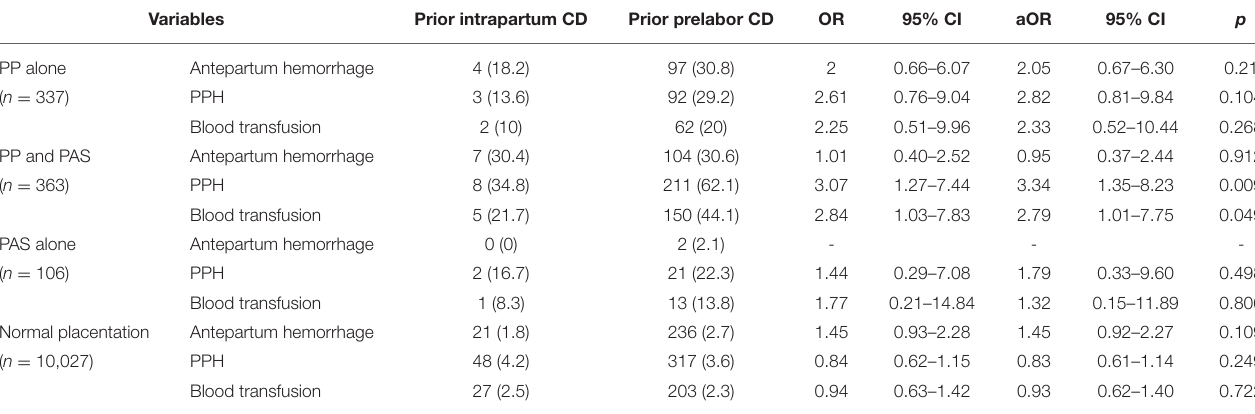
TABLE 3 | Multivariate logistic regression analysis in pregnancies complicated by PP alone, PP and PAS, PAS alone, or normal placentation.